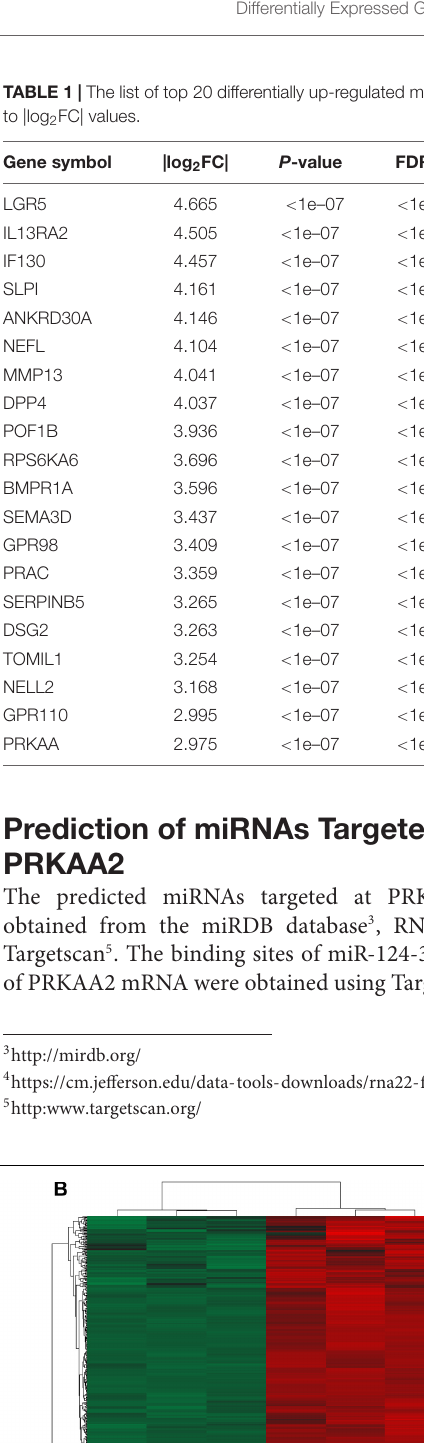
Frontiers in Cell and Developmental Biology |